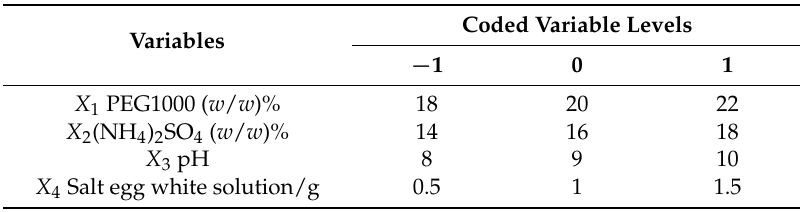
Table 1. Factors and levels in the response surface design used for the optimization of ovalbumin (OVA) extraction by an aqueous two-phase system